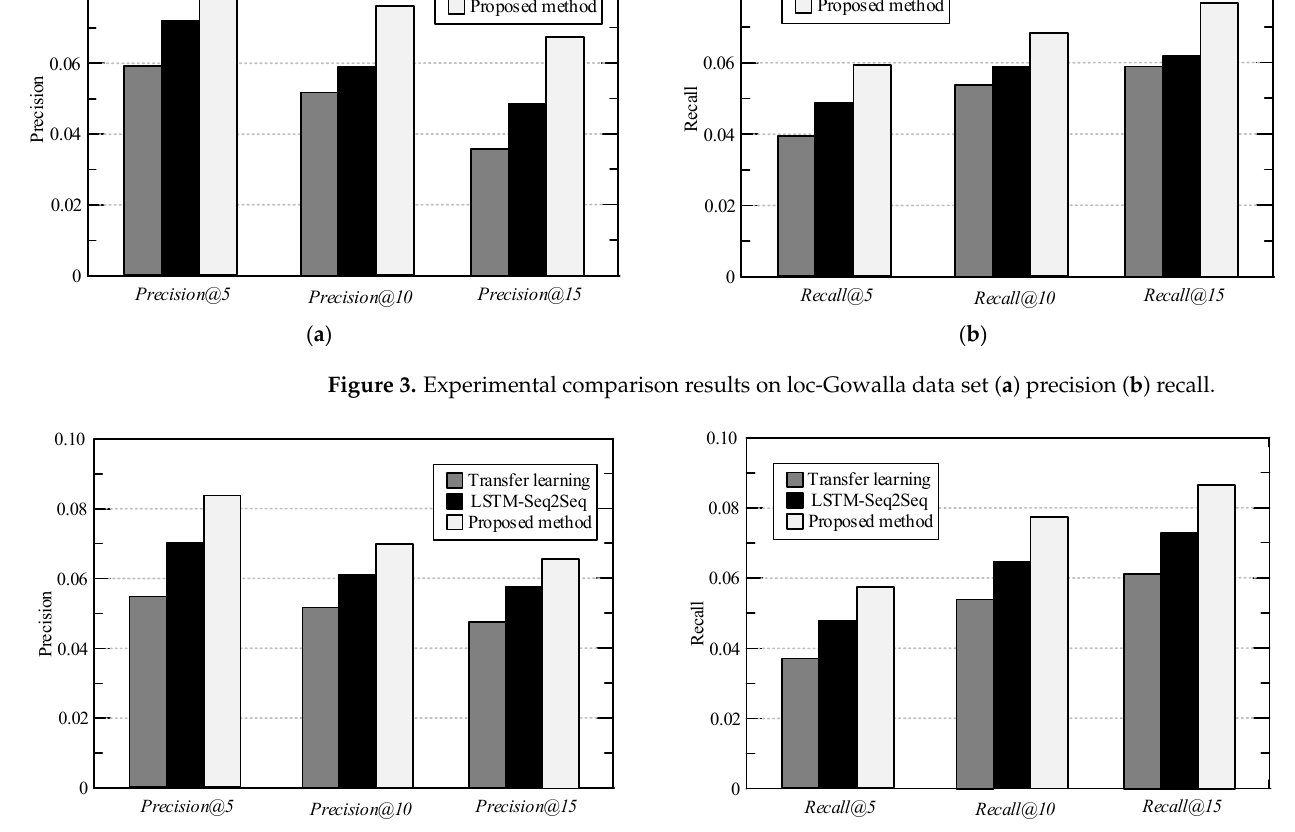
Figure 5. F1 Comparison results of different methods on different data sets. ( a ) loc-Gowalla ( b ) loc-Brightkite.